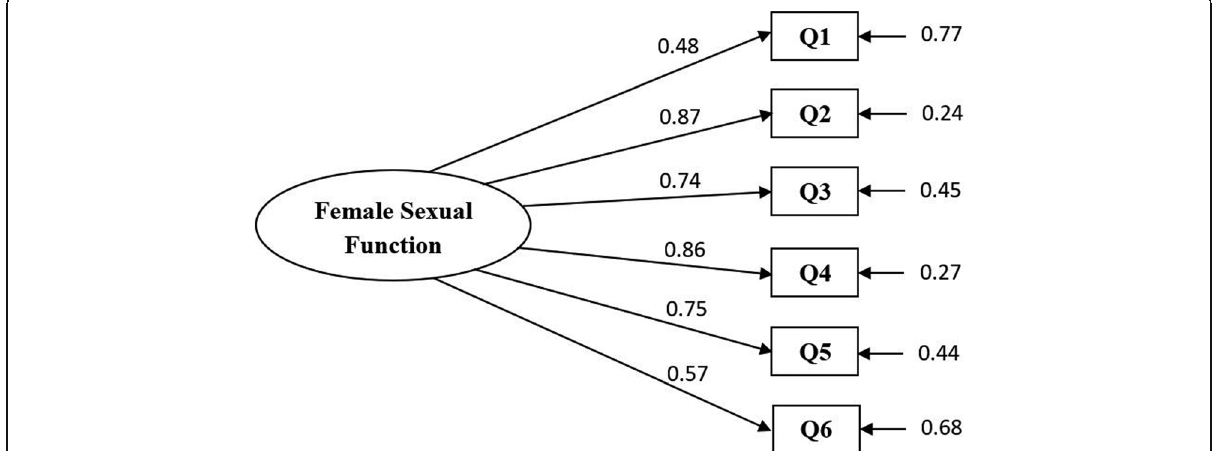
Fig. 1 The unidimensional factor model of FSFI-6 in a sample of infertile